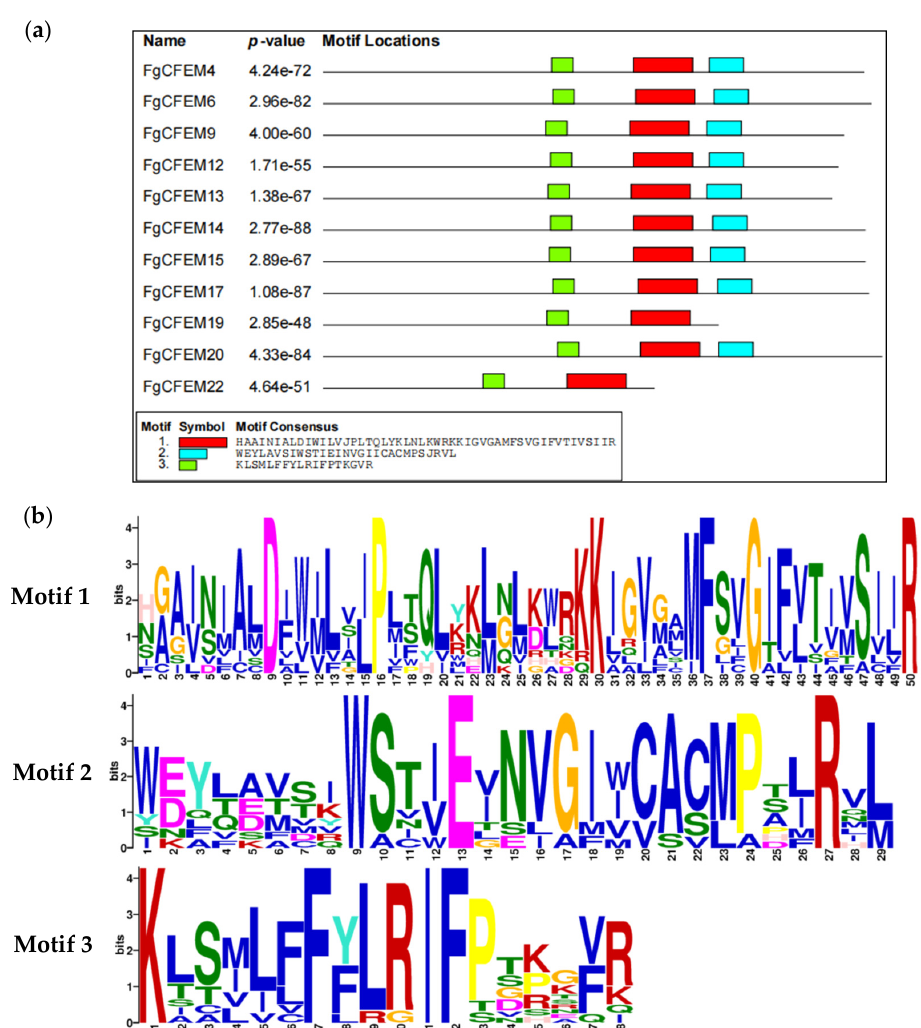
Figure 5. Identification of conserved motifs outside of CFEM domains by the MEME motif search tool. ( a ) Locations of new motifs identified. The black line represents the length of CFEM proteins, the red rectangle represents the motif 1, the blue rectangle represents motif 2, and the green protein represents motif 3; ( b ) a schematic diagram of motif 1, motif 2 and motif 3 and the conserved AA generated by MEME V4.0 software.